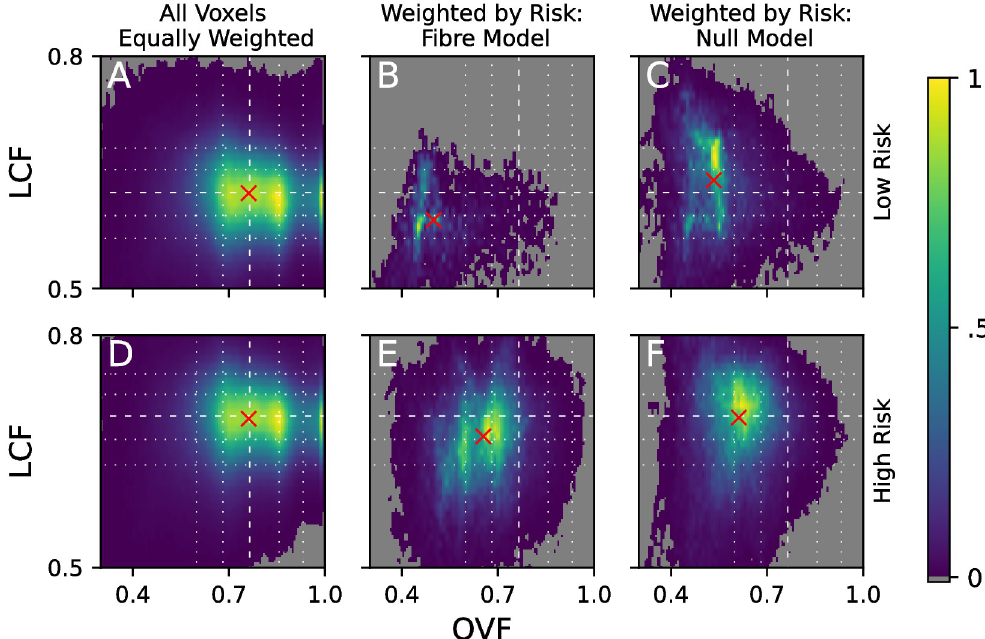
Fig 10. The distribution of LCF and OVF values in the human atria at low (A-C) and high (D-F) global risk. (A) & (D) The distribution across all the voxels in the human atria. (B) & (E) The distribution weighted by the local risk of reentry in each voxel for the fibre model. (C) & (F) The equivalent for the fibre-less null model. Note, the LCF is not defined for the fibre-less null model, but for illustrative purposes we include the LCF for the equivalent fibre model. Dashed lines: median. Dotted lines: 10 th , 25 th , 75 th and 90 th percentiles. Colourbar indicates voxel density relative to distribution maximum; regions in grey correspond to a relative density of zero. Red crosses: weighted mean of distribution.